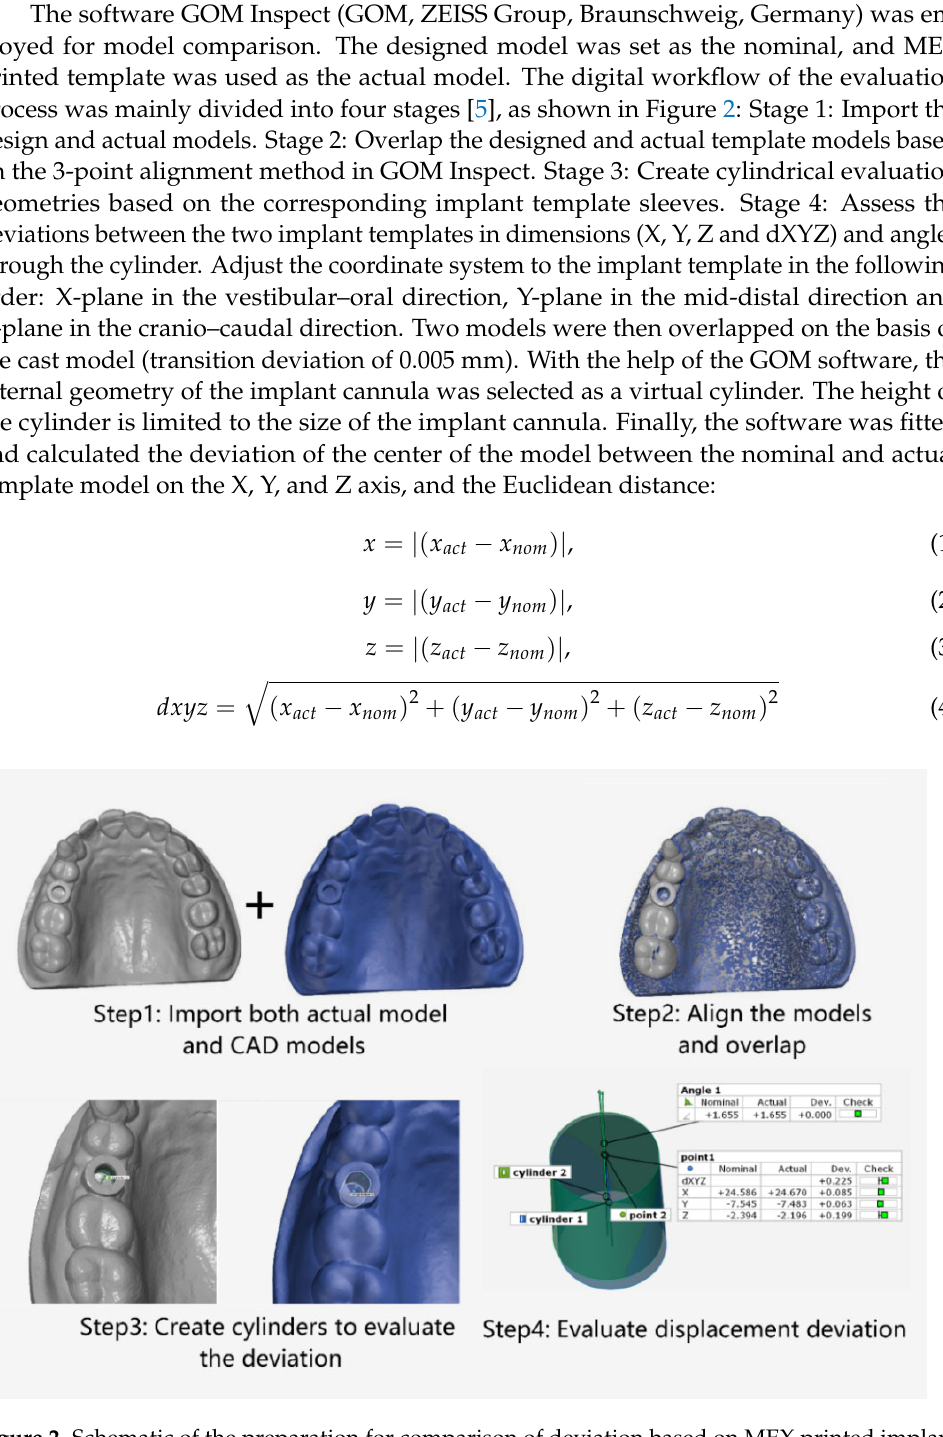
Figure 2. Schematic of the preparation for comparison of deviation based on MEX printed implant templates.